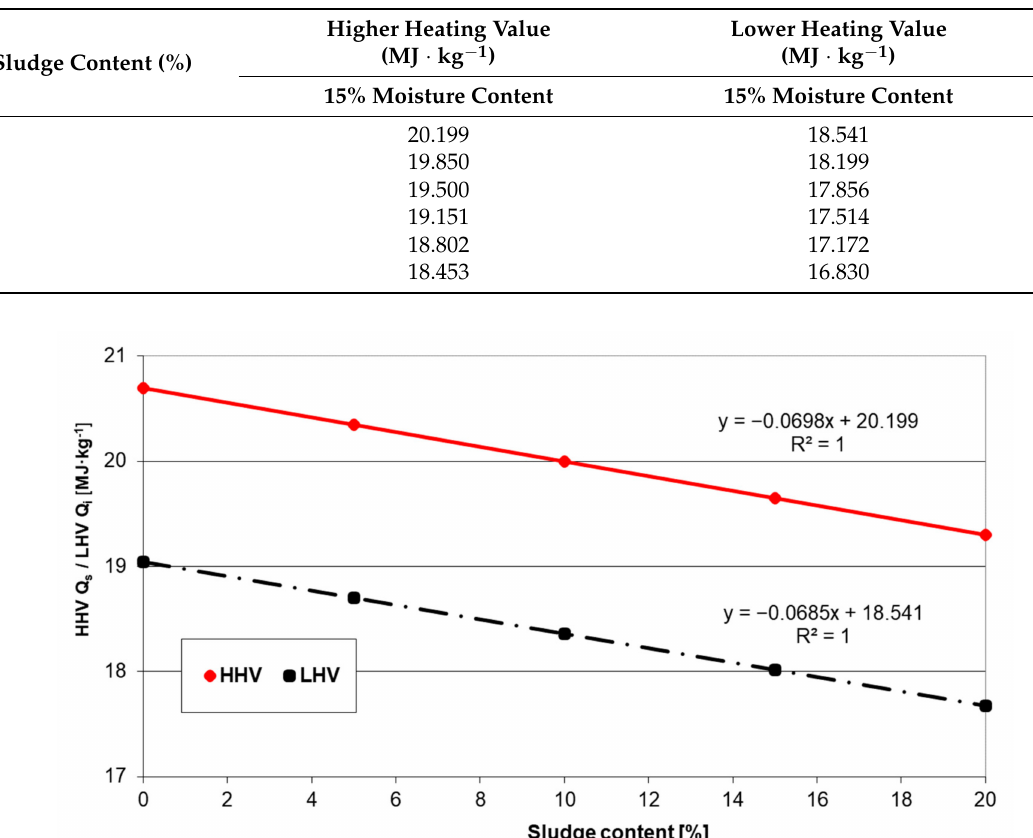
Table 5. Influence of post-flotation dairy sewage sludge in a mixture with sawdust.